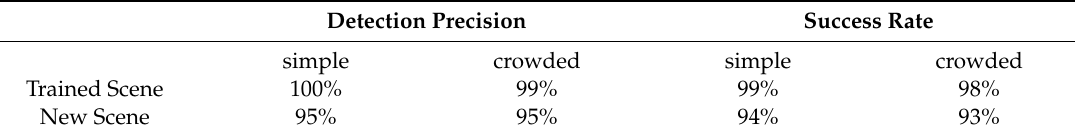
Table 3. The result of the proposed method in different scenes.